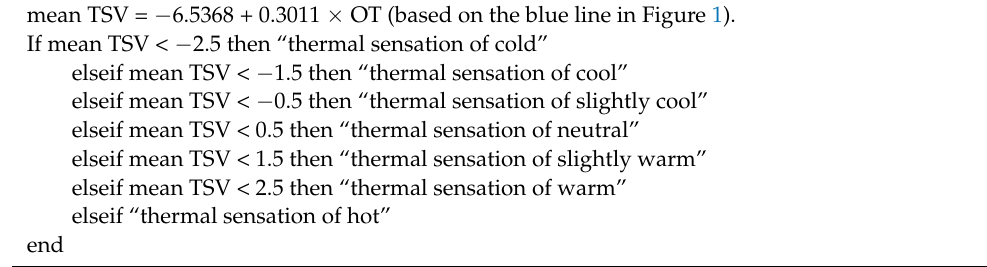
Algorithm 1. Pseudocode for deterministically establishing the response probability for each TSV category.